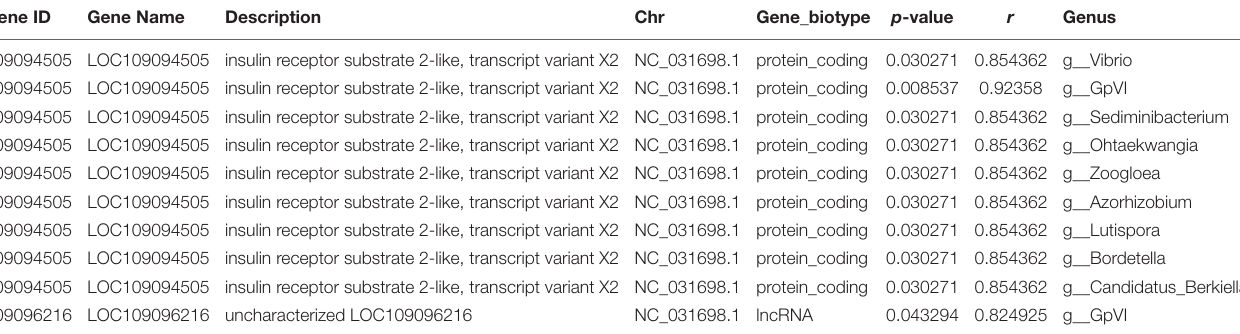
TABLE 2 | Relationship between differentially expressed genes and bacteria flora on genus level.